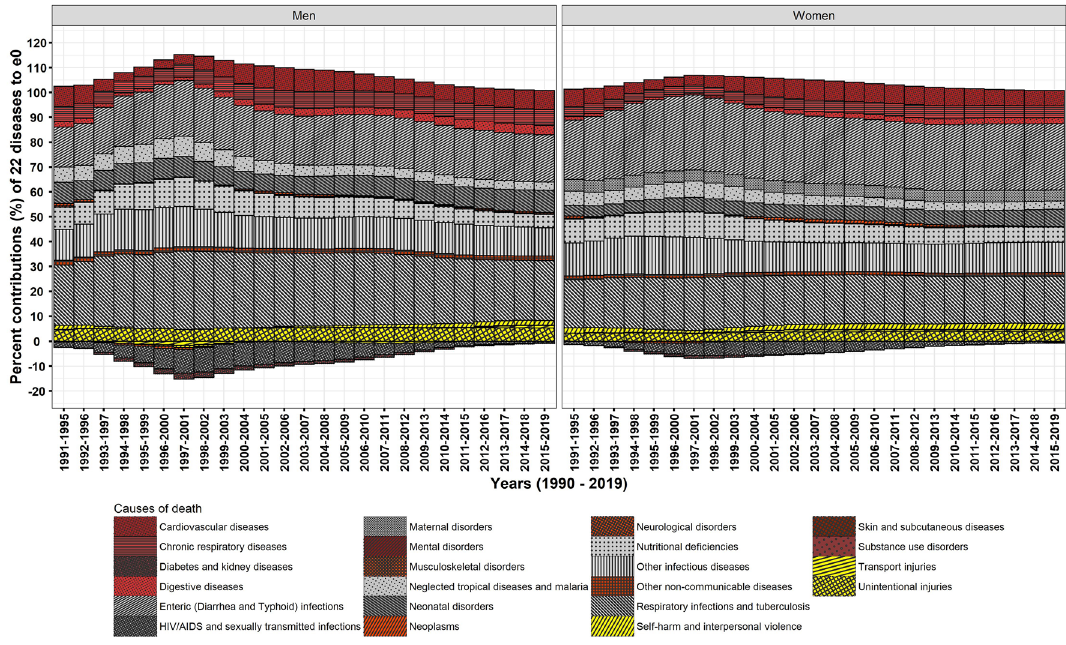
Figure 4. Temporal changes in cause-specific contributions to Δe 0 , men and women, 1990–2019.